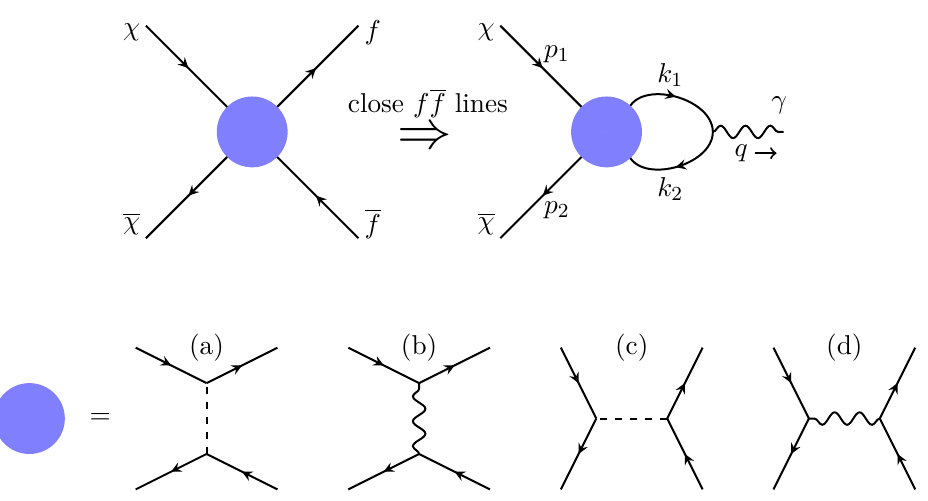
Figure 1 . Loop-induced electromagnetic interactions. In the presence of effective χ - χ - f - f interac- tions where χ is a DM fermion and f is a SM fermion, the f and f lines can be closed to form a loop diagram, which after attaching a photon line can generate electric and/or magnetic dipoles of DM. The UV structure of the effective vertex, which is important for the loop-induced dipoles, in simplified models typically can be one of the four diagrams,